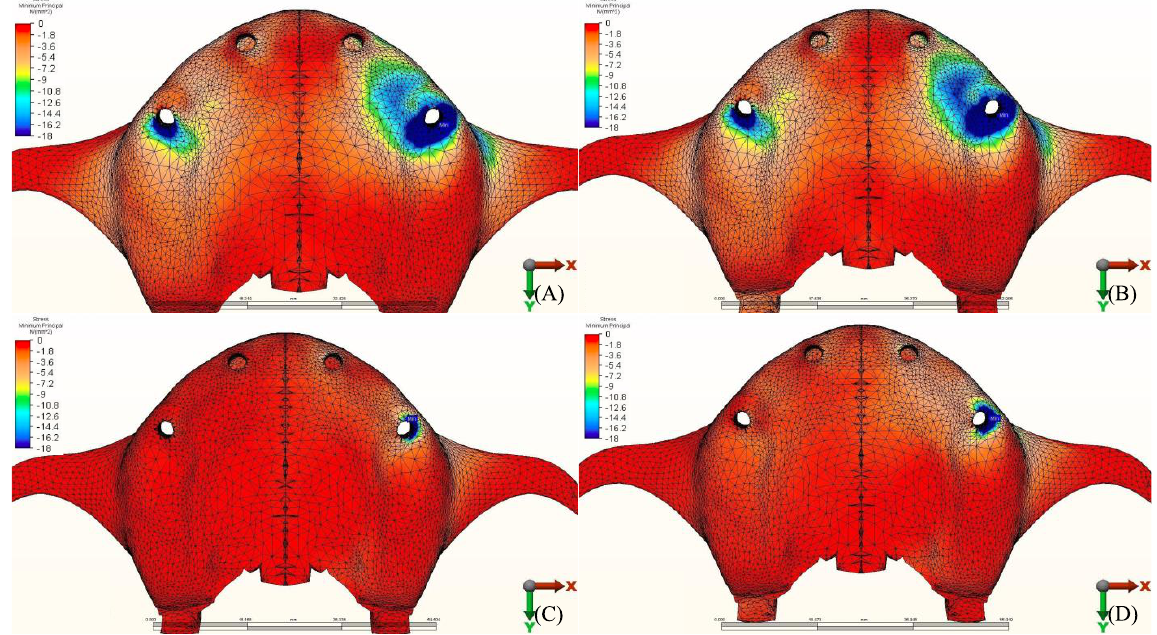
Figure 10. Pmin stress distribution in cortical bone for group 2, titanium bar with resin composite gingiva and ceramic superstructure with zirconium (Toronto bridge). ( A ) Model 2.1, opposing natural tooth. ( B ) Model 2.2, opposing tooth-supported full ceramic crown. ( C ) Model 2.3, opposing acrylic prosthesis with titanium framework. ( D ) Model 2.4, opposing implant-supported full ceramic crown.